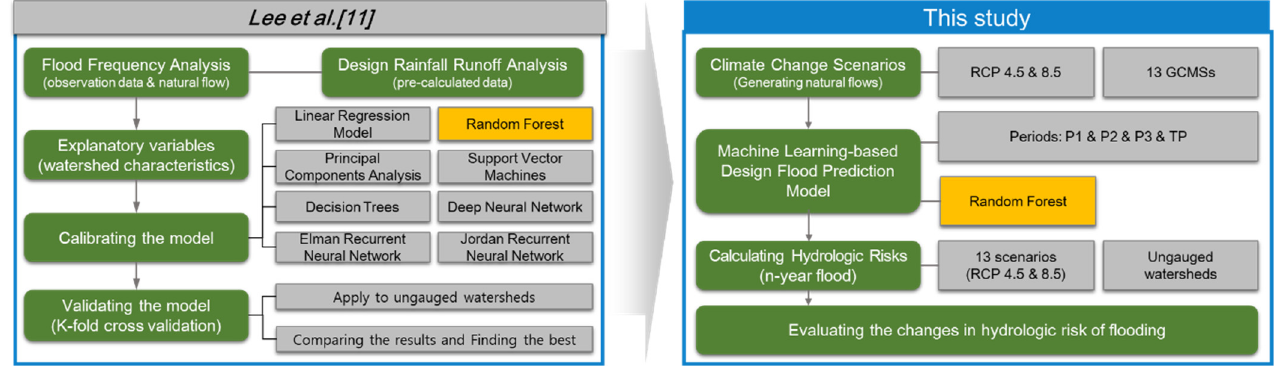
Figure 2. Extension of previous study to the hydrologic risk